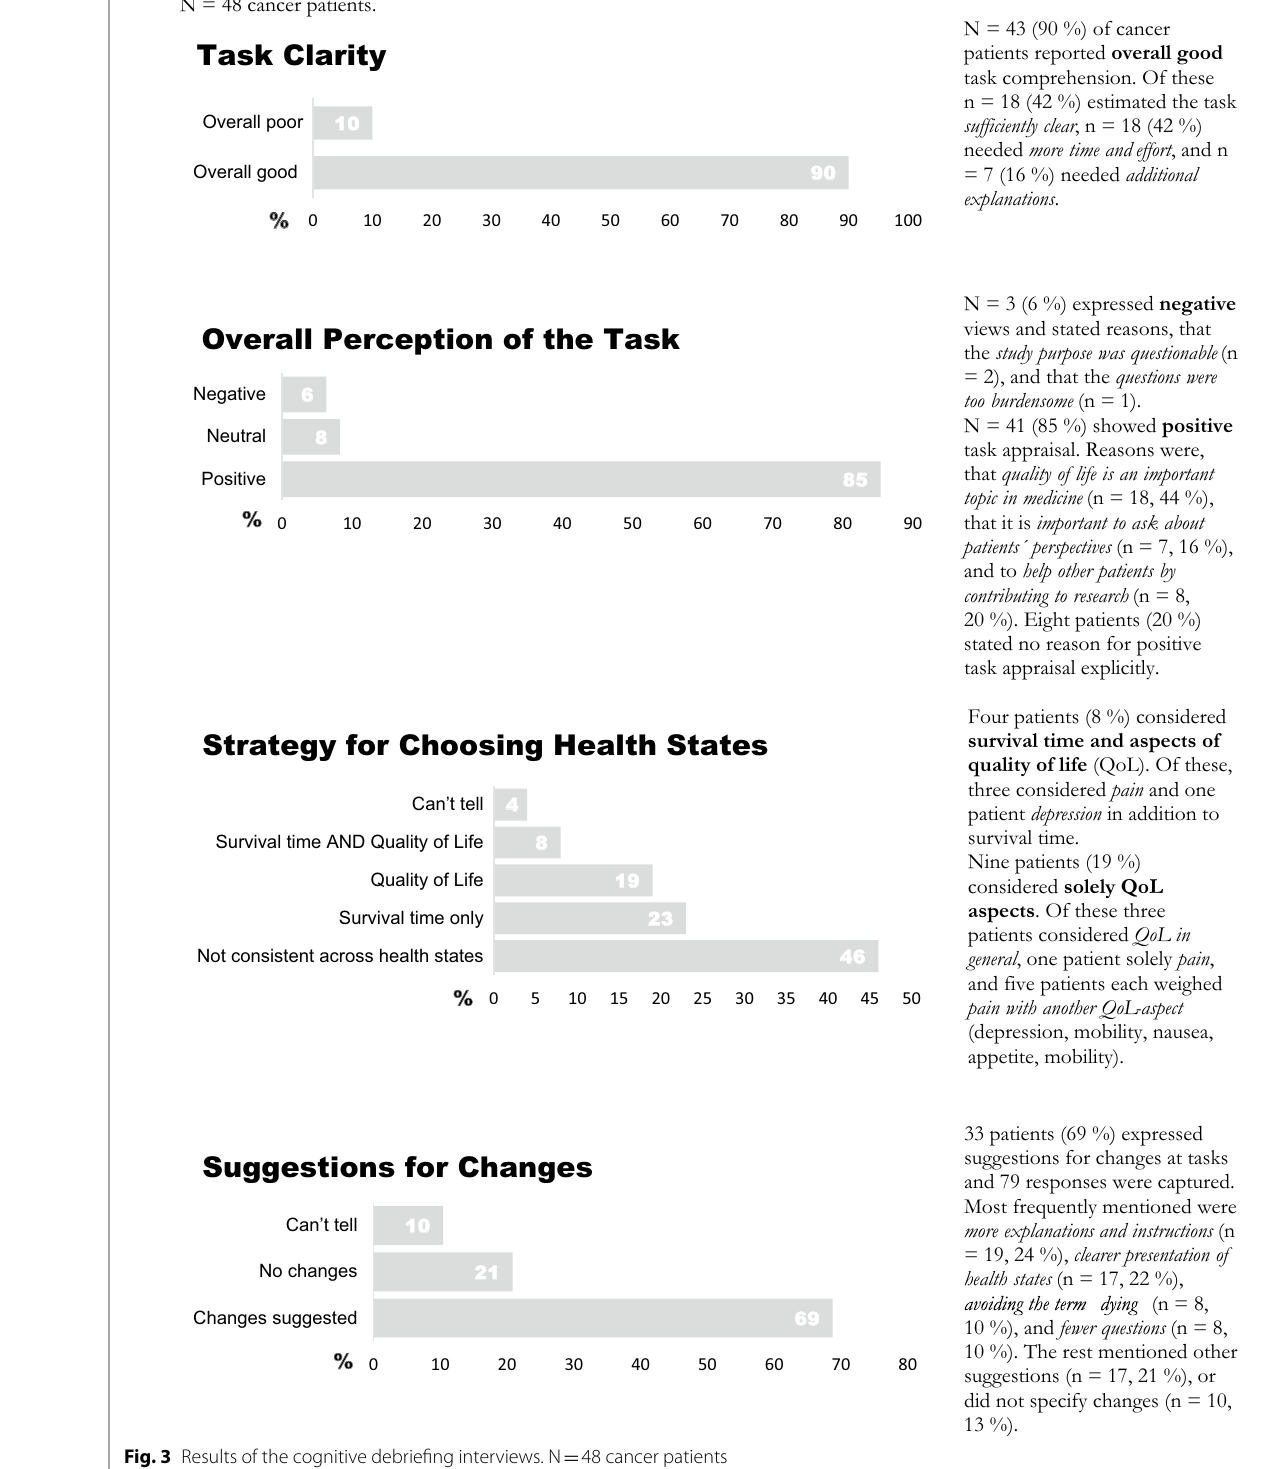
Fig. 3 Results of the cognitive debriefing interviews. N